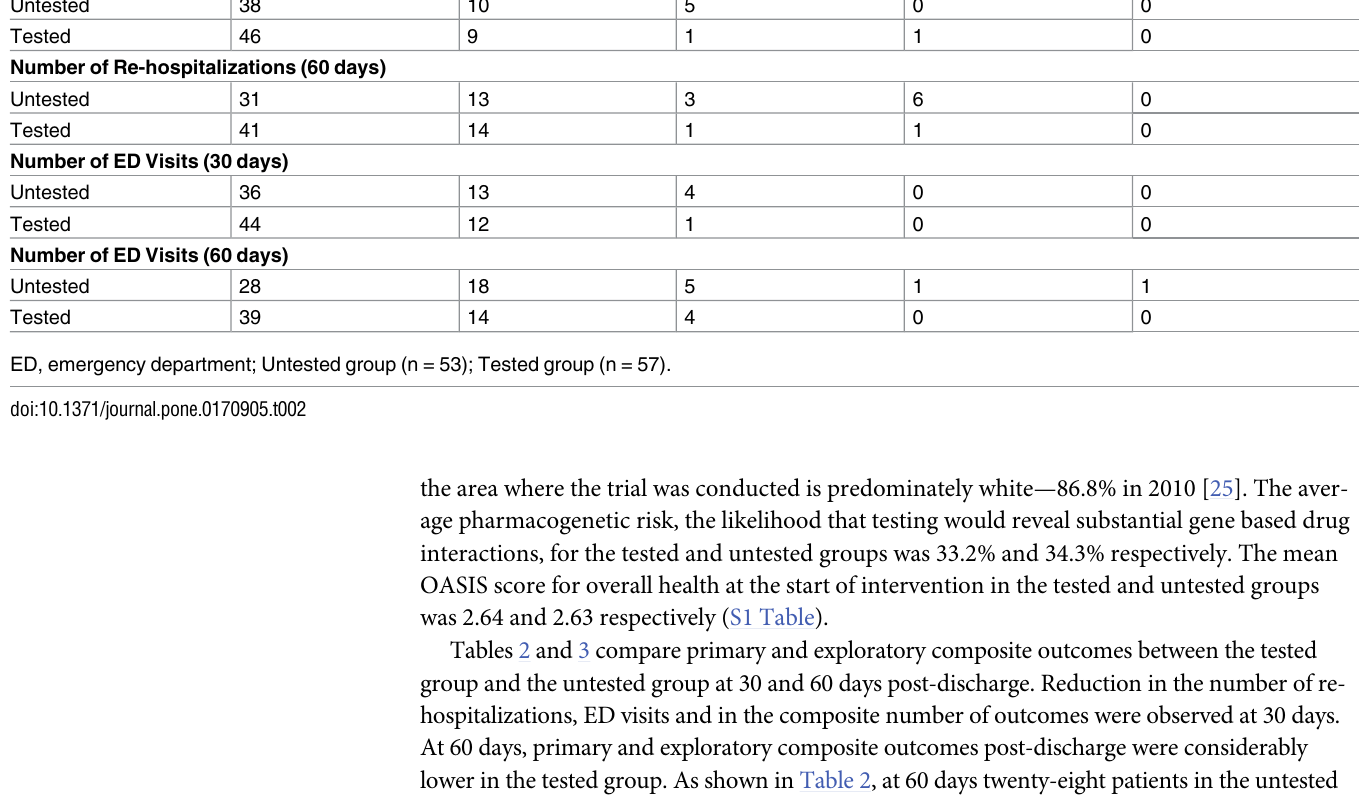
Table 3. Comparison of primary and exploratory outcomes between the treatment groups. Outcomes